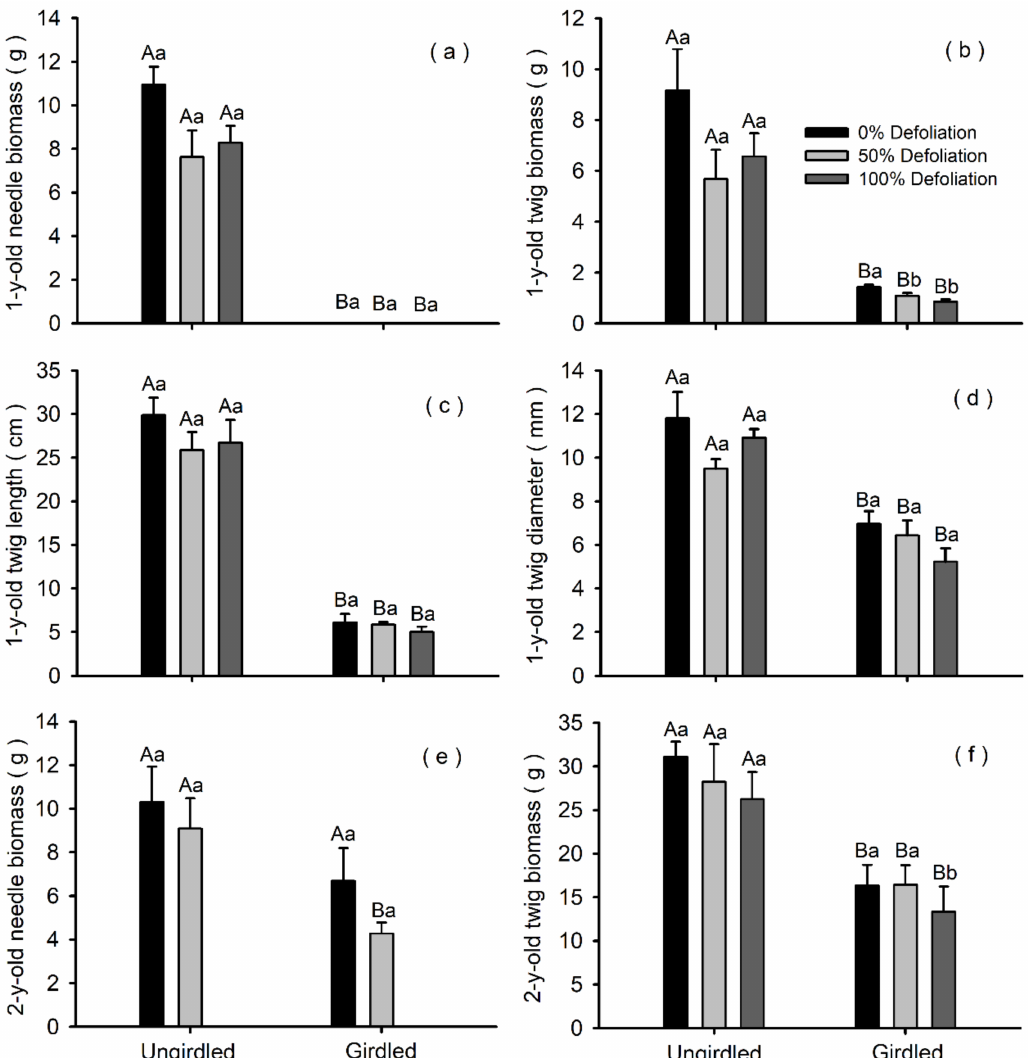
Figure 2. Needle and twig biomass and twig dimensions (length and diameter) of one-year-old (Y1; a – d ) and two-year-old (Y2; e , f ) Pinus koraiensis branches in response to girdling and defoliation treatments. One-year-old needle biomass was nil in girdled branches. Bars and arrows represent the mean and corresponding standard error, respectively, per treatment combination. Different capital letters indicate a significant effect of girdling for a given defoliation intensity ( p < 0.05). Different lowercase letters indicate significant differences among defoliation intensities for a given girdling group ( p < 0.05). Means were compared using LSD